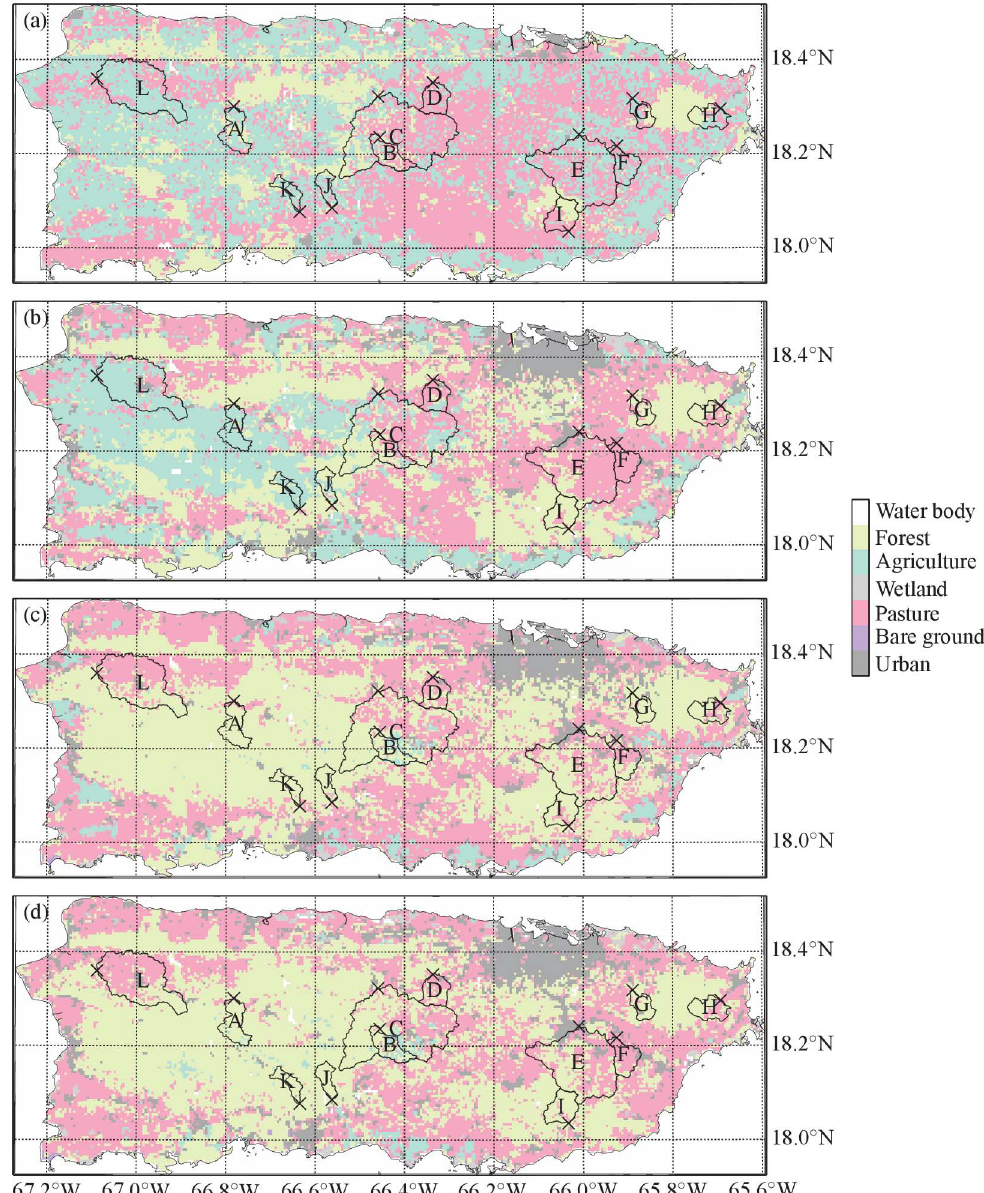
Fig. 1. Maps showing the locations of the study catchments in Puerto Rico with the generalized land-cover classifications for (a) 1951, (b) 1978, (c) 1991, and (d) 2000. Maps for 1951 and 1978 courtesy of E. H. Helmer and O. M. Ramos (USDA-IITF), respectively. Catchments identified by letters and stream gauges by crosses. All maps in this paper are presented in the Albers equal area conic projection